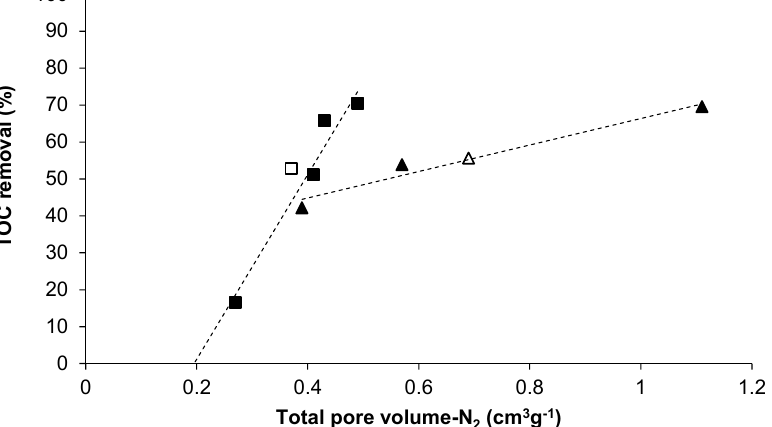
Figure 3. Relationship between TOC removal and total pore volumes of the activated carbon: open and closed squares for as prepared and heat treated CO 2 activated carbon, respectively; open and closed triangles for as prepared and heat treated H 3 PO 4 activated carbon, respectively.